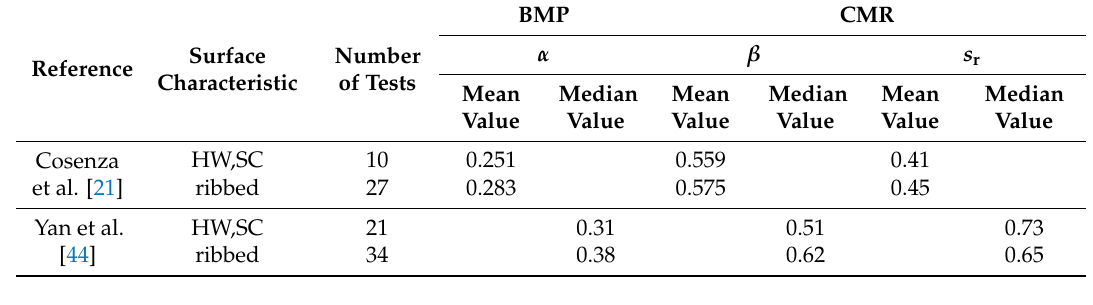
Table 4. Values of parameters based on surface characteristics.